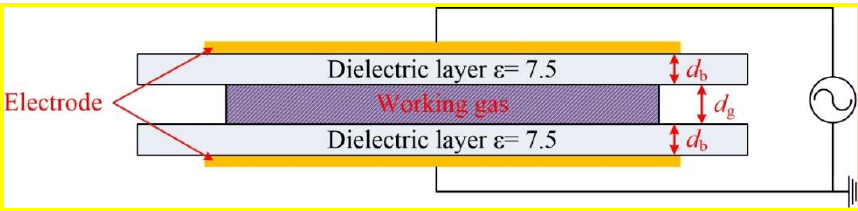
Figure 1. Schematic of the model geometry. ε denotes the relative permittivity of the dielectric layer; d b and d g represent the widths of the dielectric layer and gas gap, respectively.